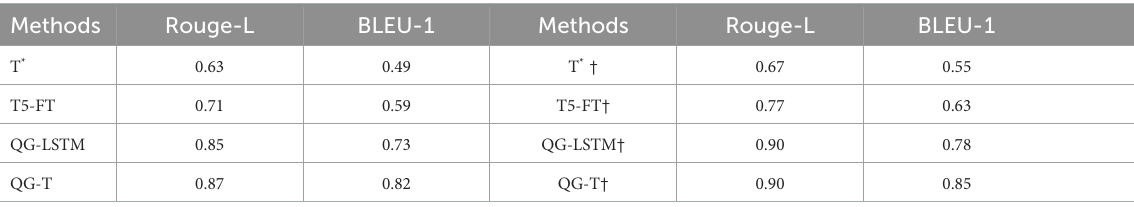
TABLE 5 The models without heuristics are evaluated by generation metrics. Methods